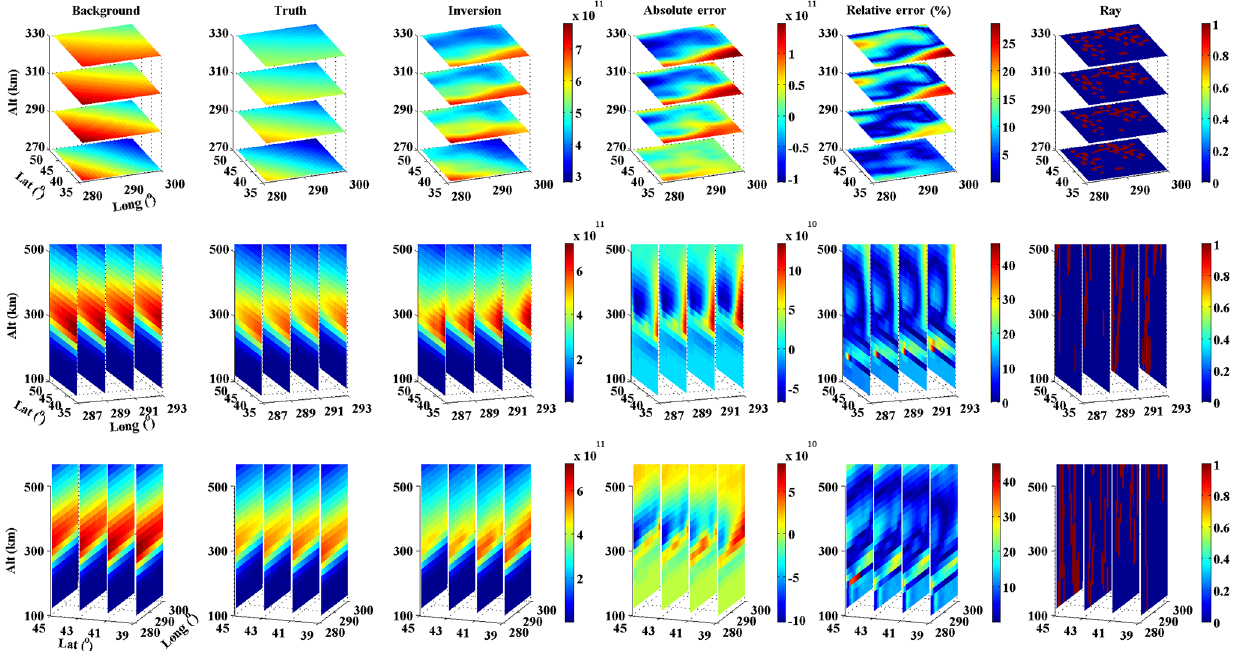
Figure 5. The reconstruction results using regularization method I under background II conditions. From top to bottom are the longitude– latitude slices at different altitudes, altitude–latitude slices at different longitudes, and longitude–altitude slices at different latitudes. From left to right are the background electron density, true electron density, reconstructed electron density, reconstructed absolute error, reconstructed relative error, and whether the satellite-receiver ray propagates through the corresponding grid or not.